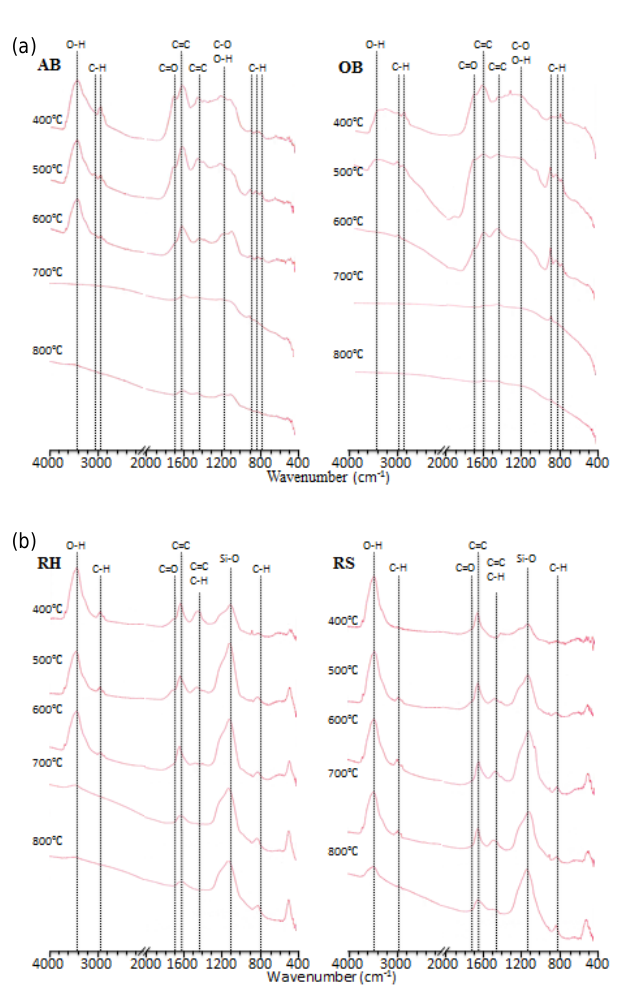
Figure 4. Cross-polarization magic angle spinning (CPMAS) 13 C nuclear magnetic resonance ( 13 C-NMR) spectra of the biochars ob- tained from (a) wood materials (apple tree branch (AB) and oak tree (OB)) as well as (b) rice residues (rice husk (RH) and rice straw